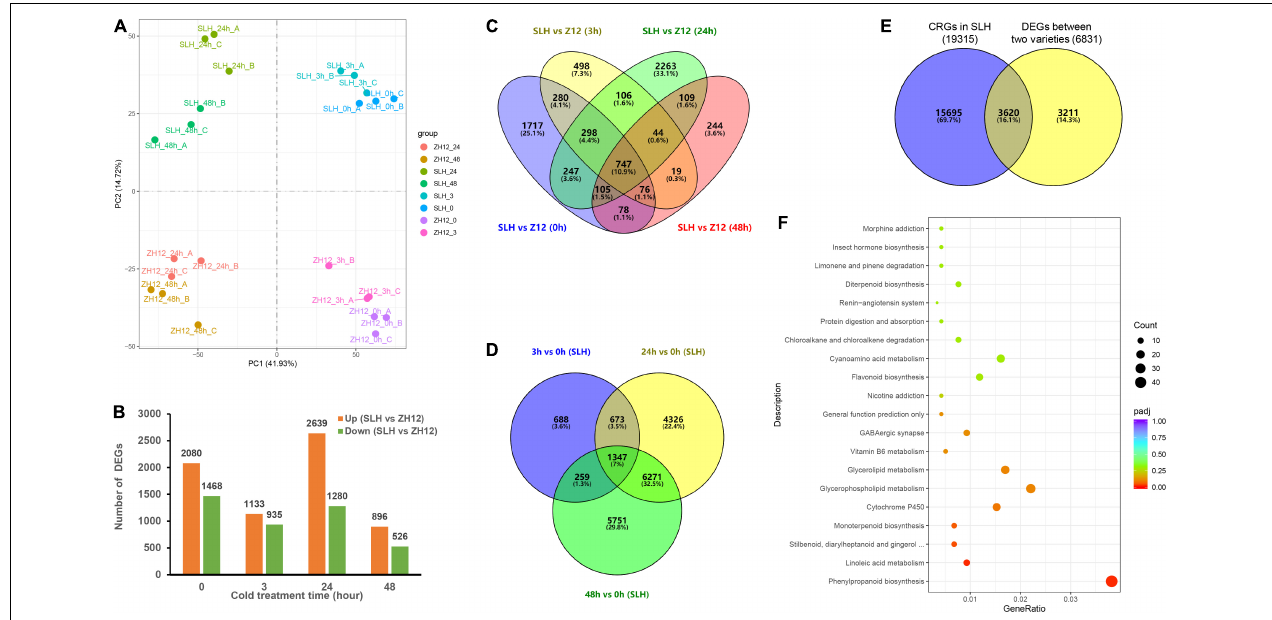
FIGURE 3 | Transcriptome analysis of two peanut cultivars in response to cold stress. (A) Principle component analysis (PCA) of transcriptome data derived from SLH and ZH12 during four time points under cold stress (0, 3, 24, 48 h, with three biological replicates per point). (B) The number of differentially expressed genes (DEGs) between SLH and ZH12 exposed to cold treatment. DEGs were filed out using the DESeq2 R package with the parameter of | log 2 (fold change)| > 1 and an adjusted P -value < 0.01. (C) The Venn diagram of DEGs between the two cultivars at four different cold treatment time points. (D) The Venn diagram of Cold Responsive Genes (CRGs) in SLH in the three cold exposure times (3, 24, and 48 h) compared to control (0 h). (E) The Venn diagram showing 3,620 putative Cold Tolerance Genes (CTG) in peanut. The yellow circle refers to the total 6,831 DEGs during the cold treatments between the two cultivars as shown in panel (C) , and the blue circle represents the total 19,315 cold-responsive genes (CRGs) in SLH as indicated in panel (D) . (F) KEGG enrichment analysis of the 3,620 Cold Tolerance Genes (CTG) in peanut.